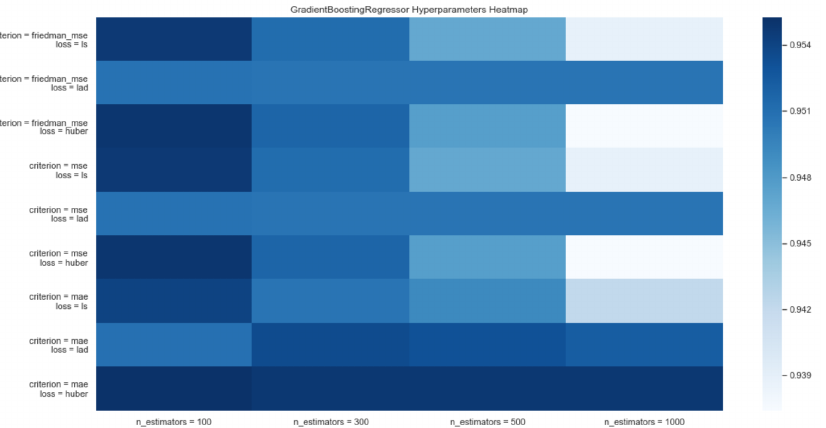
Figure 11. RandomForestRegressor Hyperparameter Heat Map.